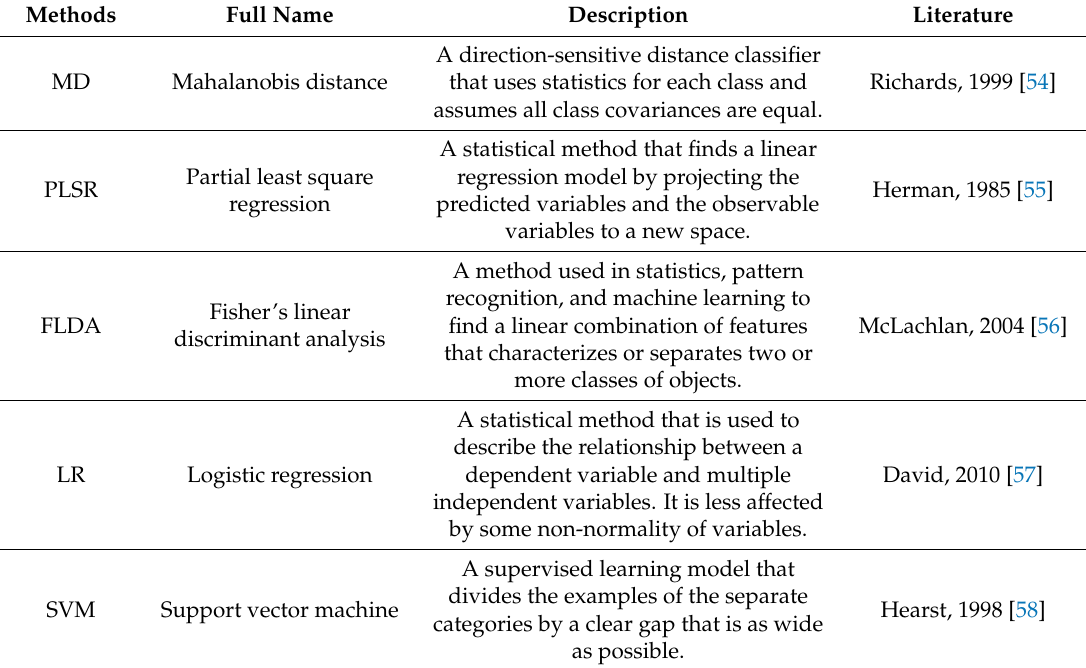
Table 3. Characteristics of existing methods used in this study for disease